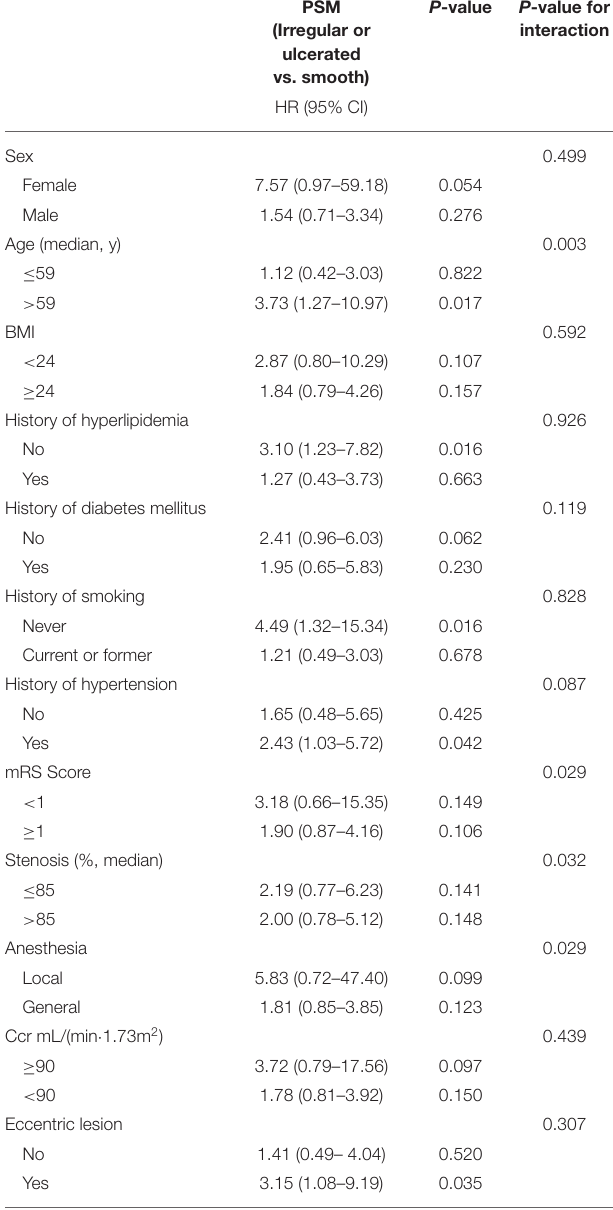
TABLE 4 | Subgroup analysis for association between PSM and long-term